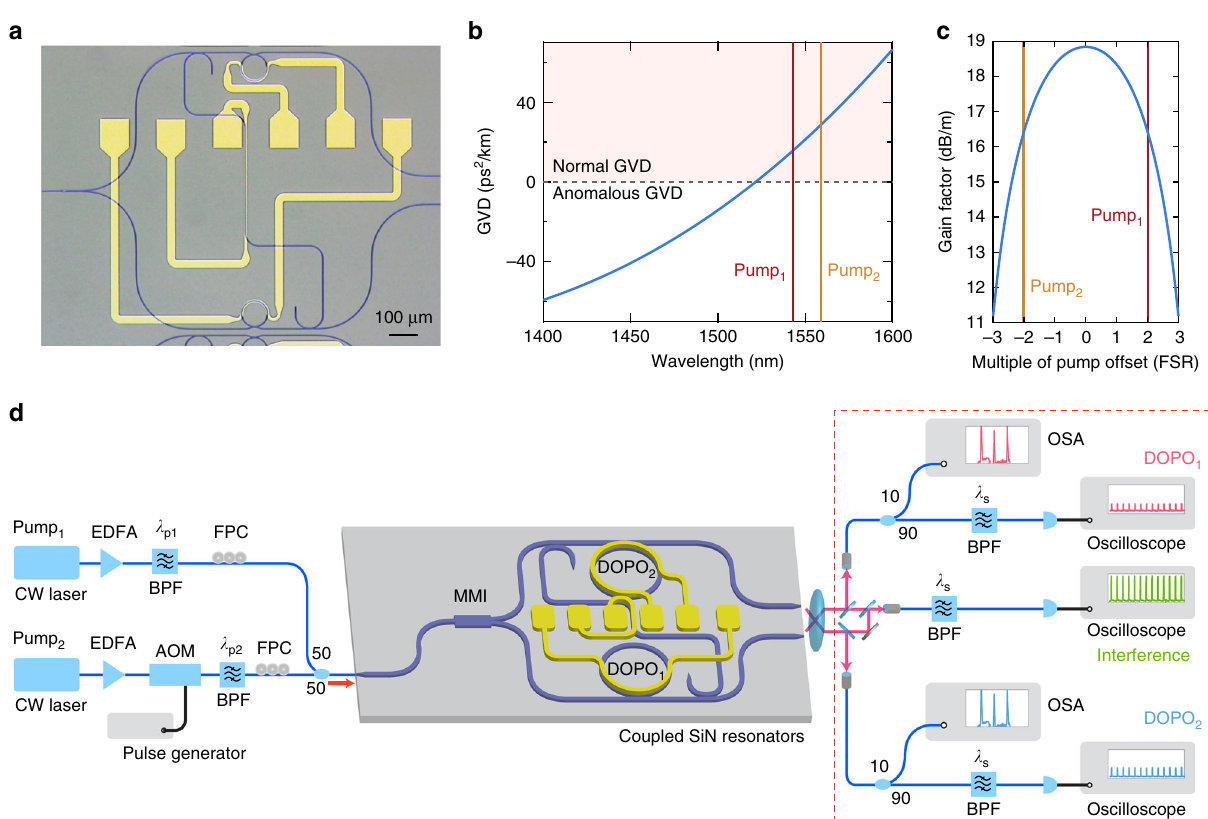
Fig. 2 Experimental schematic of coupled DOPOs. a Microscope image of the device. The pump waves are split on-chip and sent to DOPO 1 (bottom) and DOPO 2 (top). A coupling waveguide after DOPO 1 is used to send a fraction of the DOPO 1 fi eld to DOPO 2 . b Simulated group-velocity dispersion (GVD) of the SiN microresonator for the fundamental transverse electric (TE) mode. The waveguide cross section is 730 × 1050 nm 2 . The region of normal GVD is shaded, and the pump wavelengths are indicated with vertical lines. c Calculated parametric gain for 1 W of combined pump power. The pump waves are each located two free spectral ranges (FSRs) from the degeneracy point. d Experimental setup for measurement of coupled DOPO system. Two-frequency nondegenerate pumps are sent into the SiN chip. The output is collected using an aspheric lens and sent to a free-space interferometer to measure the interference signal. EDFA erbium-doped fi ber ampli fi er, BPF bandpass fi lter, AOM acousto-optic modulator, FPC fi ber polarization controller, MMI multimode interference splitter, OSA optical spectrum